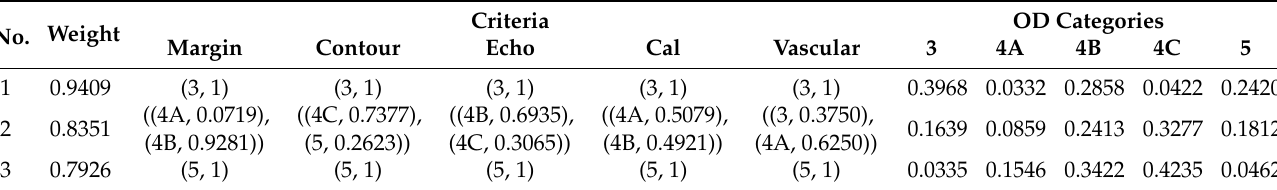
Table 7. BRB of Doctor No. 3 under the deletion